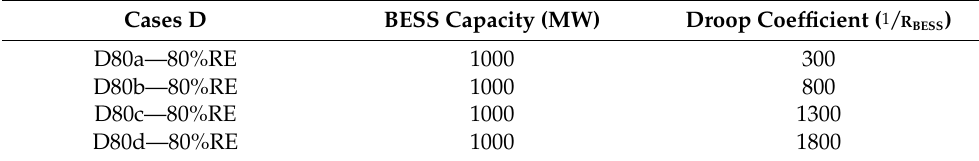
Table 9. Group D, different droop coefficient, fixed BESS capacity, no PFC from SGs.